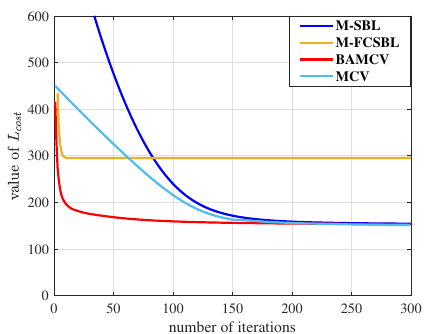
Figure 13. Convergence curves of different methods using measured